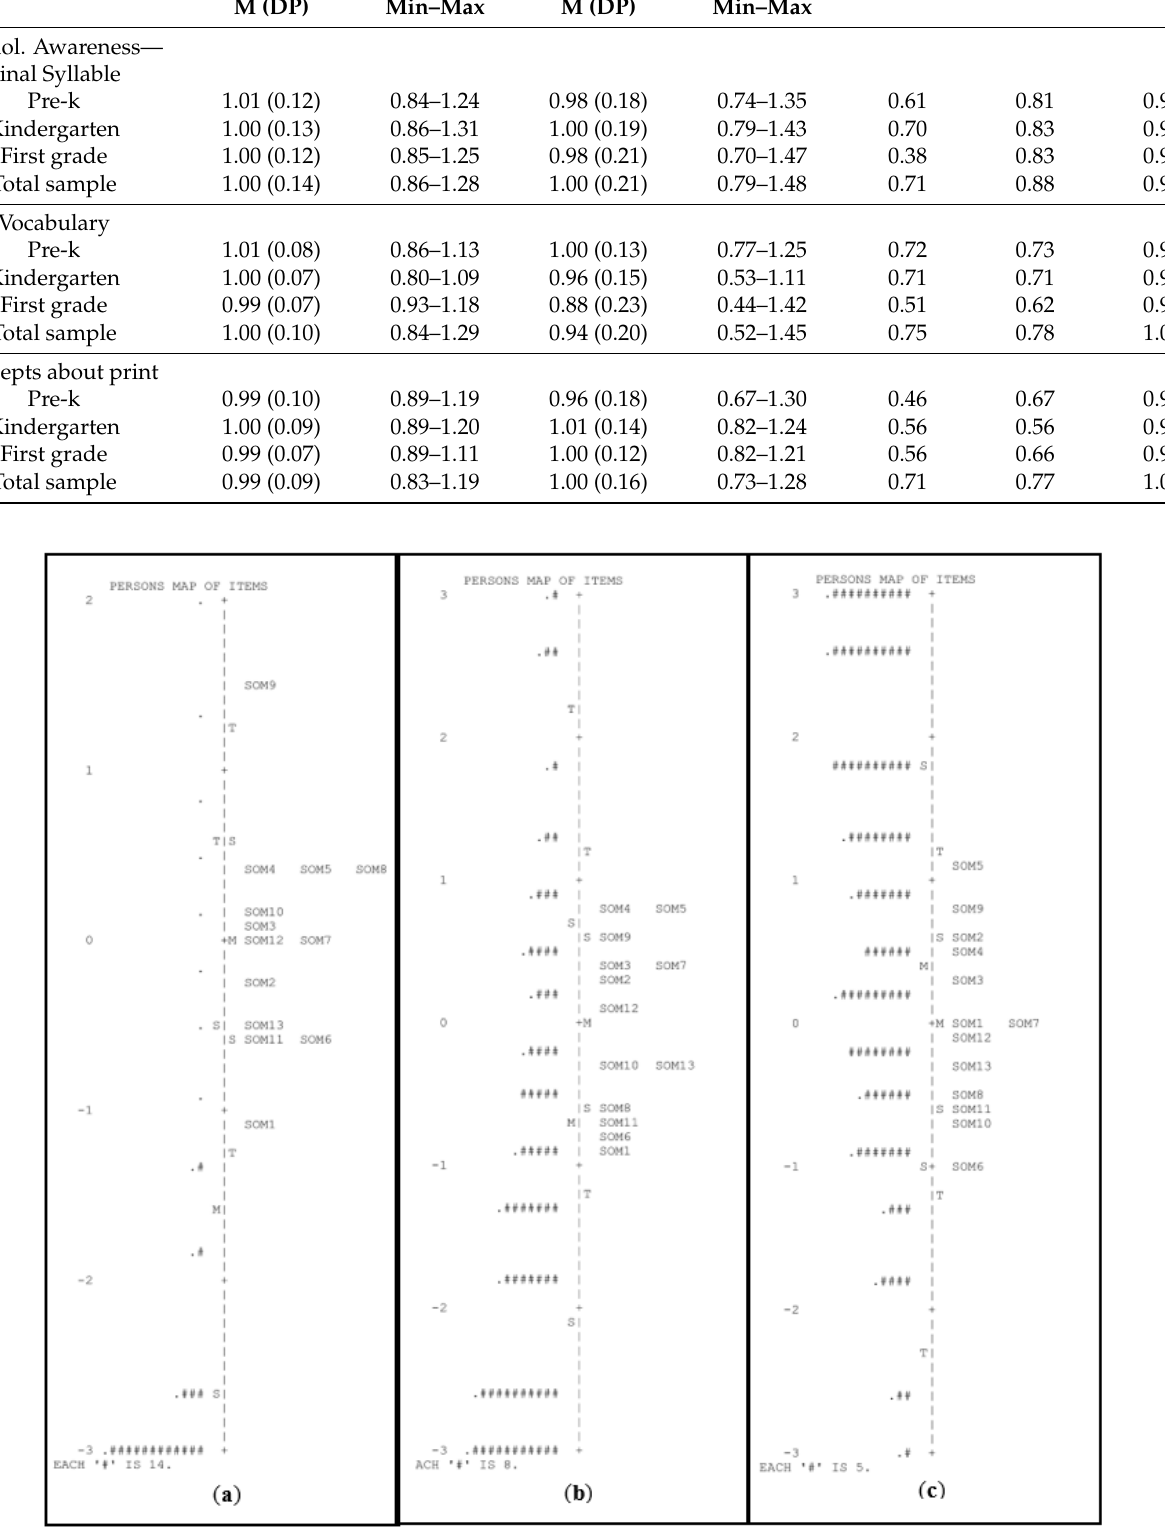
Figure 1. Person–item maps for the task of phonological awareness of the initial syllable in pre-K ( a ), kindergarten ( b ), and first grade of primary school ( c ) . # Refers to the number of persons.